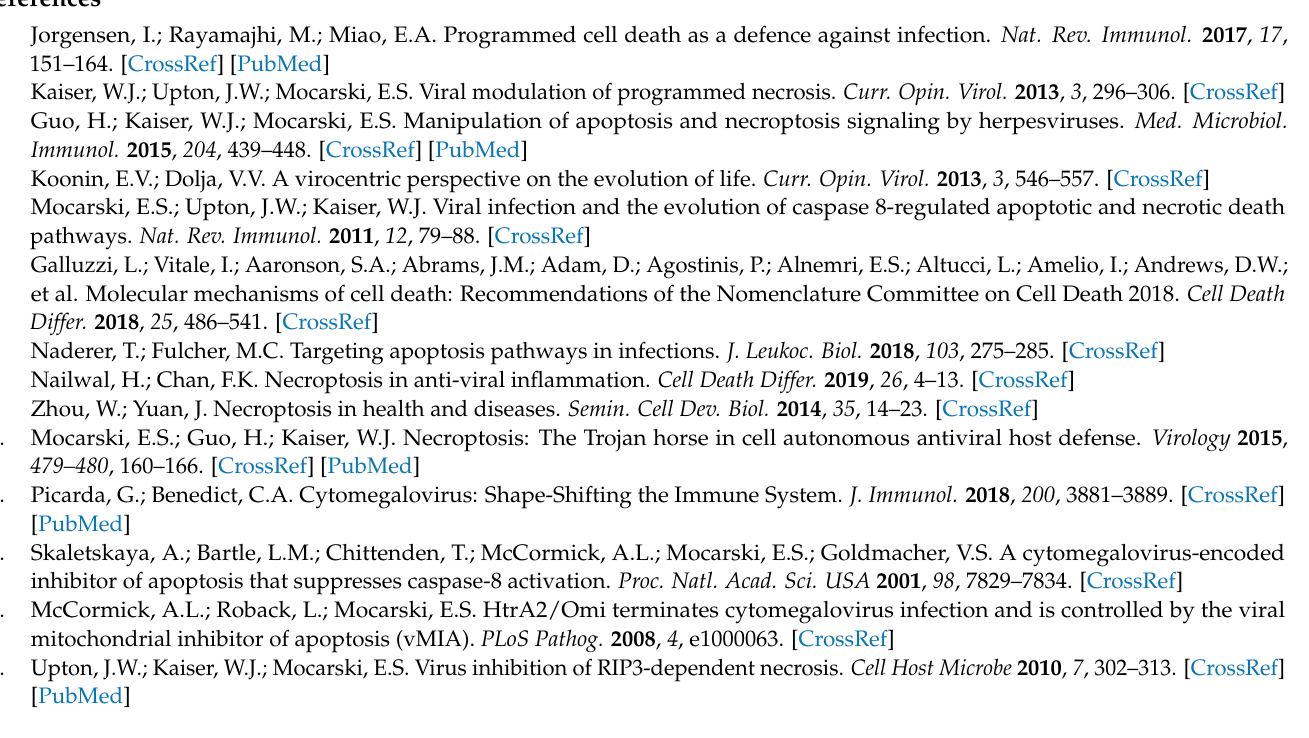
Casp8 − / − Ripk3 − / − BMDM infected at MOI = 0.5 over 9 days. Replication was measured as described in Figure S1. (C) Replication of K181 or indicated mutant MCMV in WT or Casp8 − / − Ripk3 − / − BMDM infected at MOI = 0.5 for 5 d. For each experiment (A–C), data shown are pooled results from at least three experiments where error bars indicate standard error and mean for each dataset. (D) Replication of K181 and ∆ M38.5/M41.1 in salivary glands of littermate Casp8 +/ − Ripk3 − / − or Casp8 − / − Ripk3 − / − mice at 14 dpi. Mean is indicated for each